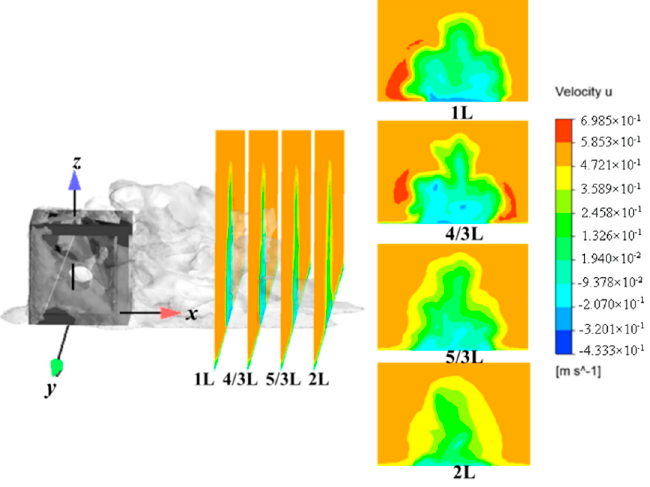
Figure 10. The volume of the wake region of the upwelling reef with the AI of 0°.